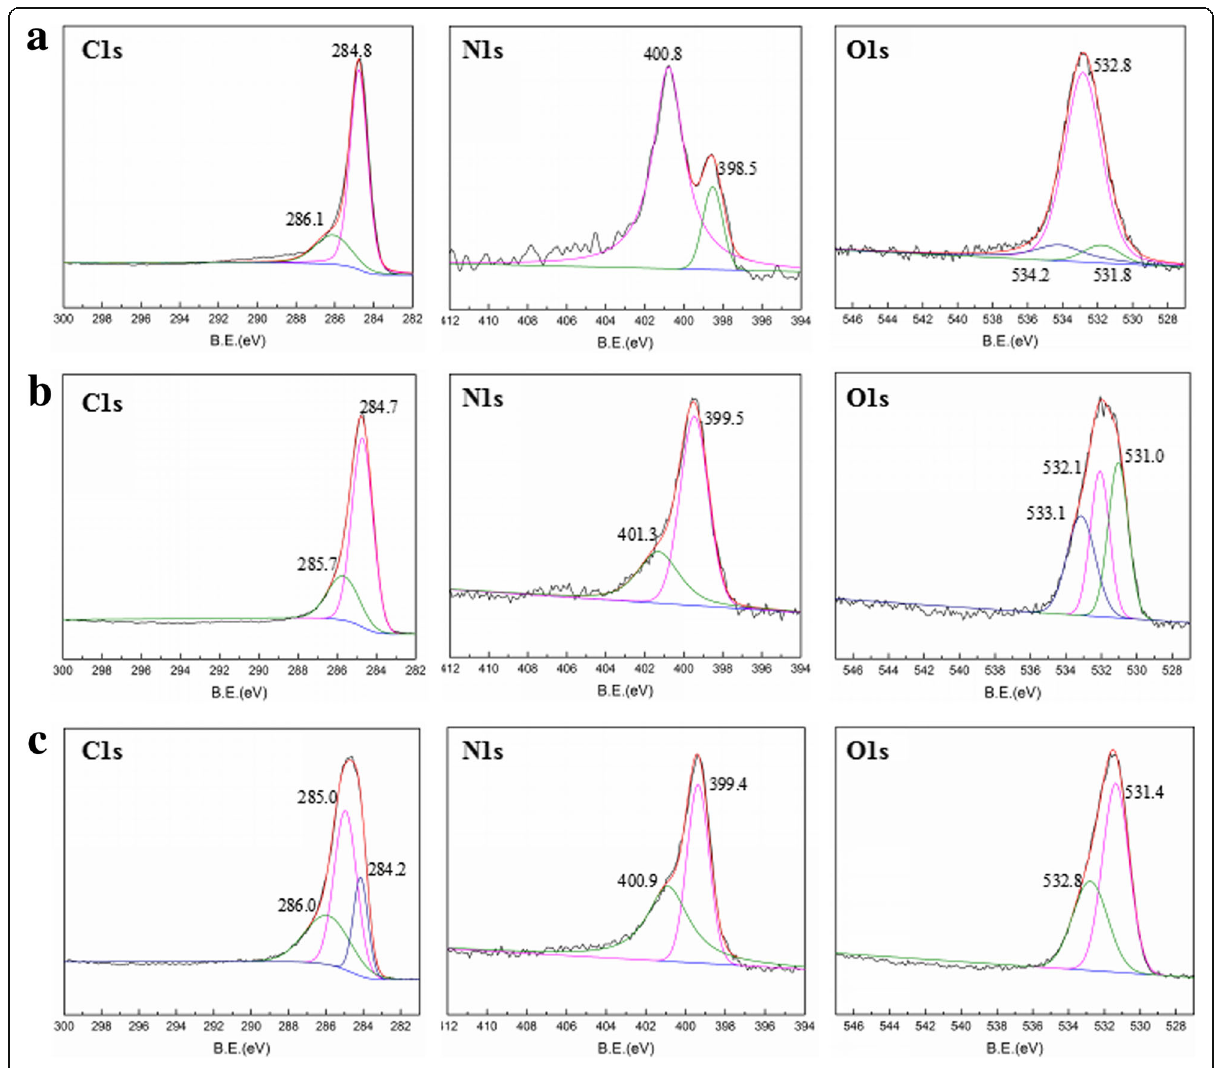
Fig. 2 XPS spectra of C 1s , N 1s , and O 1s for NOMC ( a ), PANI/NOMC-0.5( b ), and PANI/NOMC-4 ( c )